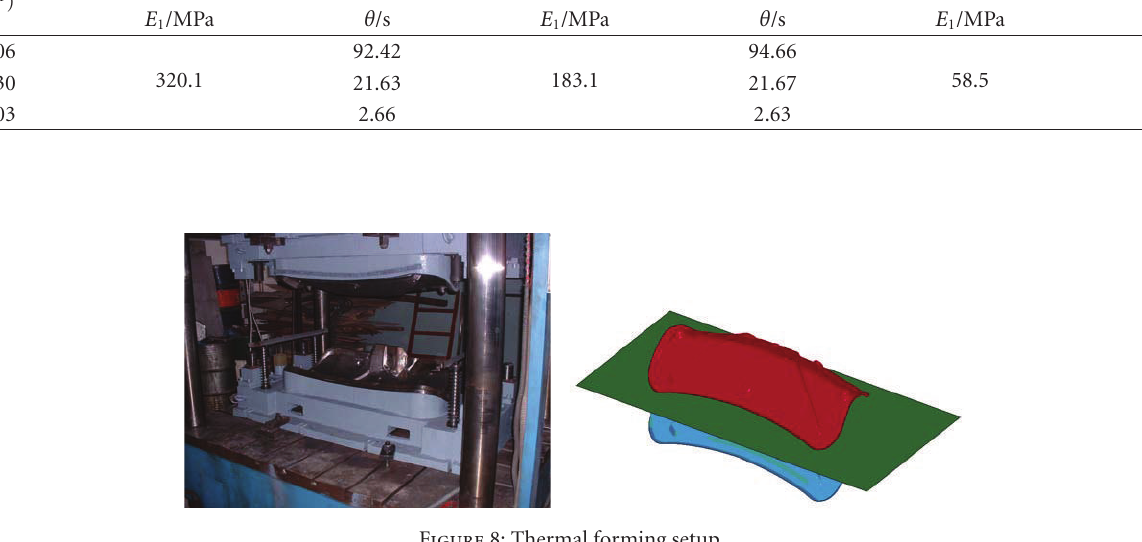
Figure 8: Thermal forming